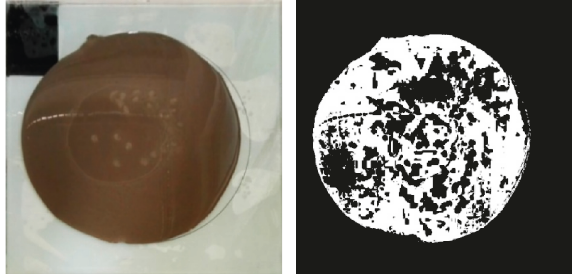
Figure 5: The segmentation results of